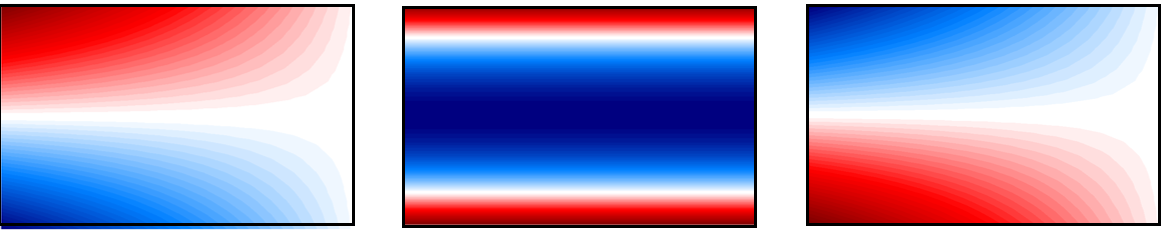
Figure 6. Beam solution (True solution ε xx , ε xy , ε yy